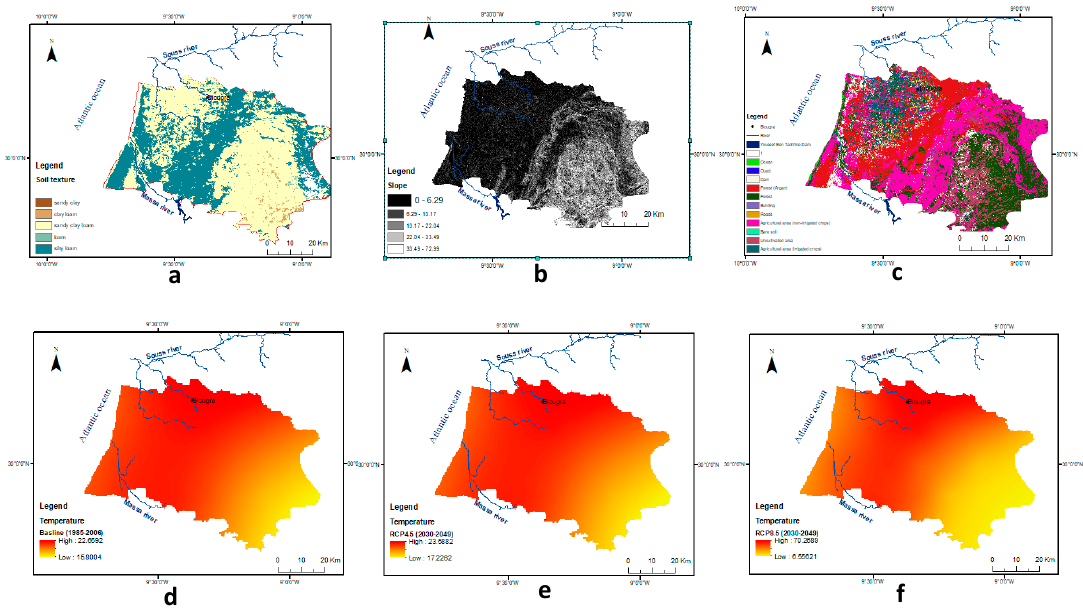
Figure 3. Land suitability factors ( a ) soil texture, ( b ) slope, ( c ) land use, ( d ) T baseline, ( e ) T projected under RCP4.5, ( f ) T projected under RCP8.5.